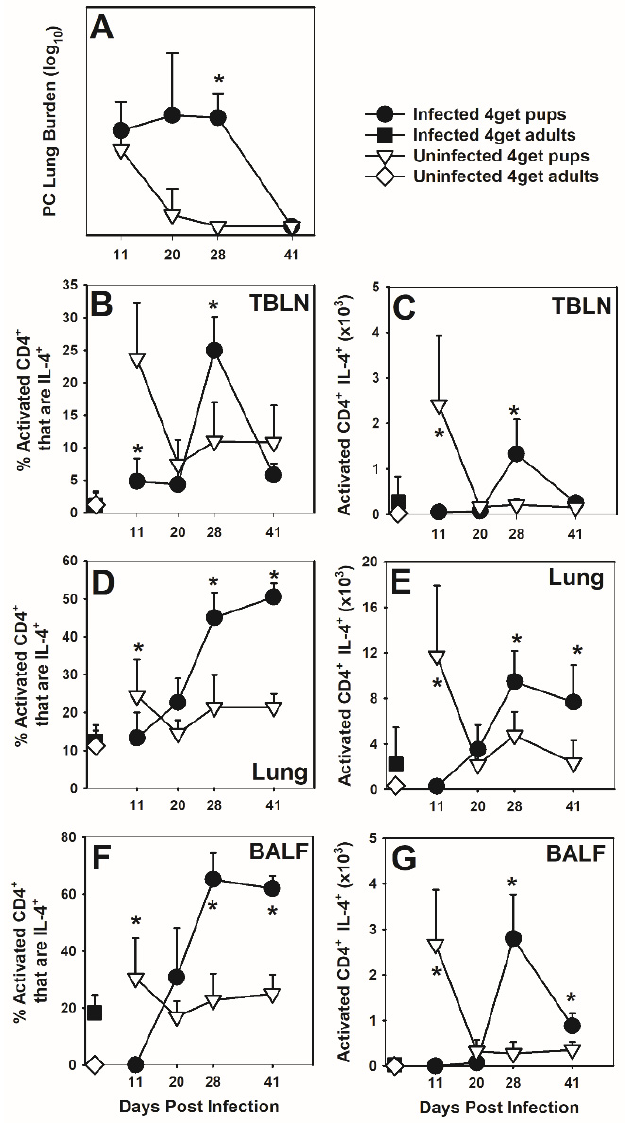
Figure 1. Activated CD4 lymphocytes from P. murina infected neonates and adults express IL-4. 4get pups (2-day-old) and adults ( ≥ 8 weeks) were infected with 5 × 10 5 P. murina organisms/g of body weight. At indicated days post infection, BALF, right lung lobes, and TBLN were collected from 4–6 mice per group. ( A ) P. murina lung burden was determined microscopically. Cells from TBLN ( B , C ), lung digest ( D , E ), and BALF ( F , G ) were treated with PMA and ionomycin, stained with antibody against CD4, CD44 and CD62L, and analyzed by flow cytometry for IL-4-eGFP expression. CD4+ cells expressing high CD44 and low CD62L were considered to be activated. Data represent the mean ± SD and are representative of 2 independent experiments. * p ≤ 0.05, comparing P. murina infected 4get neonates to P. murina infected 4get adults.